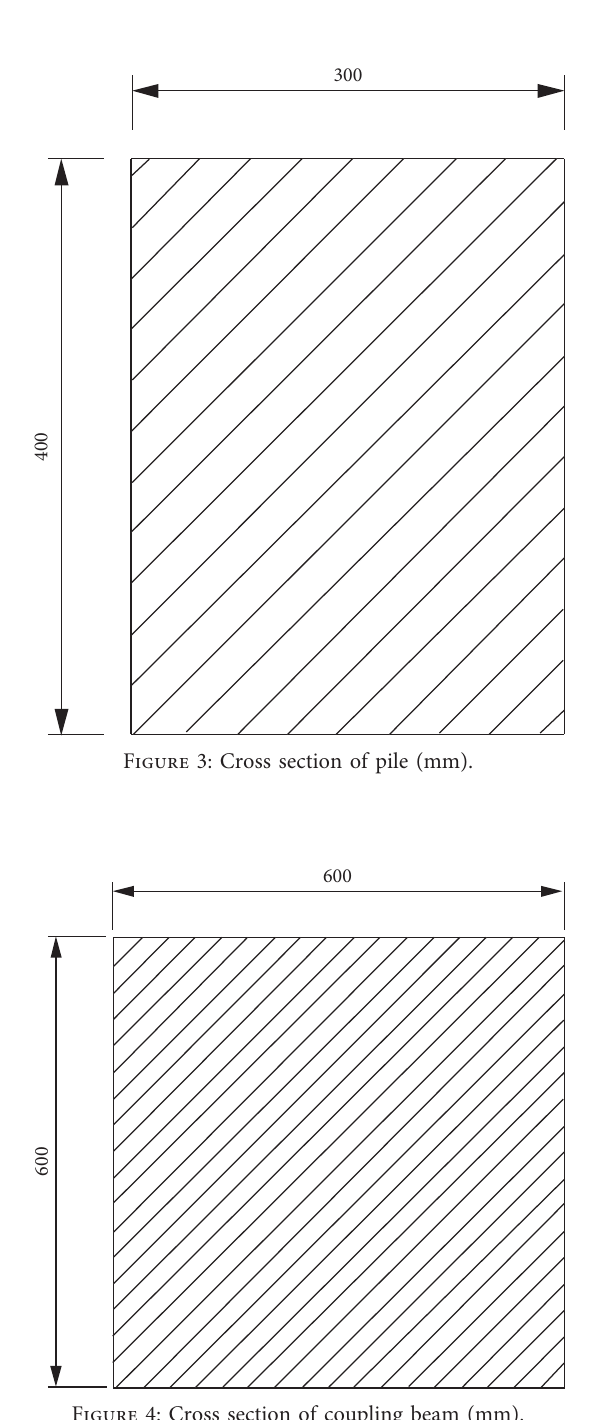
Figure 4: Cross section of coupling beam (mm).